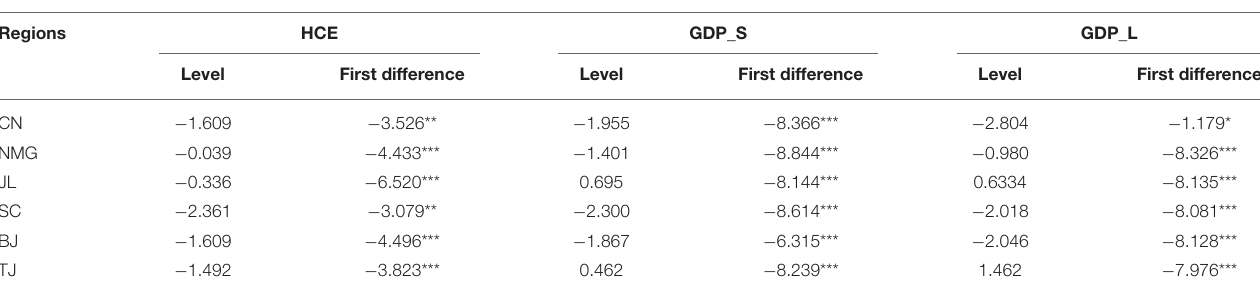
TABLE 3 | The results of ADF unit root tests for healthcare expenditure (HCE) and GDP. Regions